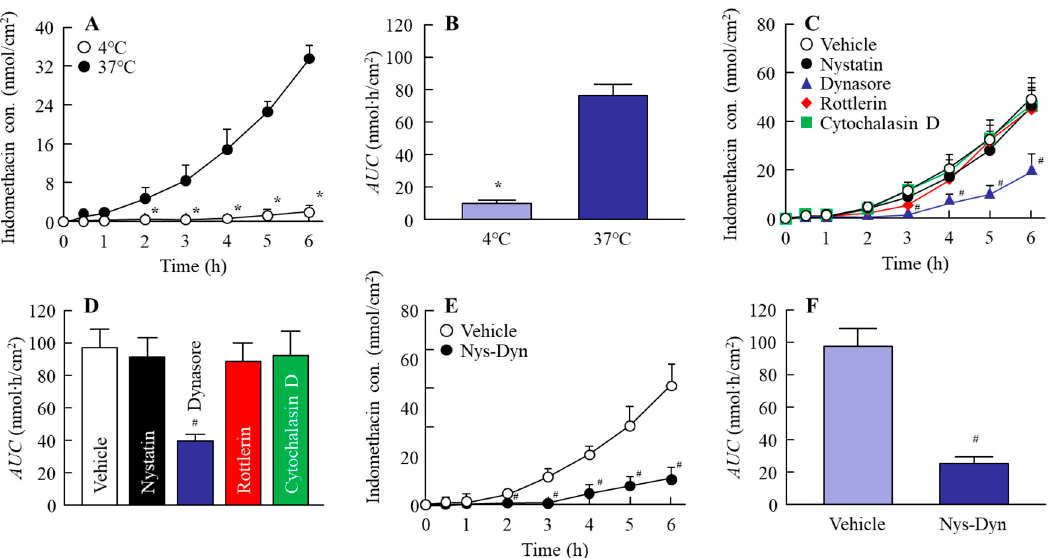
Figure 5. Endocytosis enhances the penetration of indomethacin nanoparticles in the jejunum. ( A , B ) Changes in the penetration profile ( A ) and area under the drug concentration-time curve in the reservoir chamber (AUC) ( B ) of indomethacin nanoparticles in the jejunum under 4 ◦ C or 37 ◦ C conditions. ( C – F ) Changes in the penetration profile ( C , E ) and AUC ( D , F ) of indomethacin nanoparticles in jejunum treated with endocytosis inhibitors. Nys-Dyn indicates co-treatment with nystatin and dynasore. n = 5–8. * P < 0.05 vs. 37 ◦ C conditions. # P < 0.05 vs. vehicle for each category. Dynasore significantly attenuated the penetration of indomethacin nanoparticles in the jejunum. Table 1. Pharmacokinetic parameters for IND-NPs penetration in jejunum treated under cold (4 °C) temperature conditions or with endocytosis inhibitors.